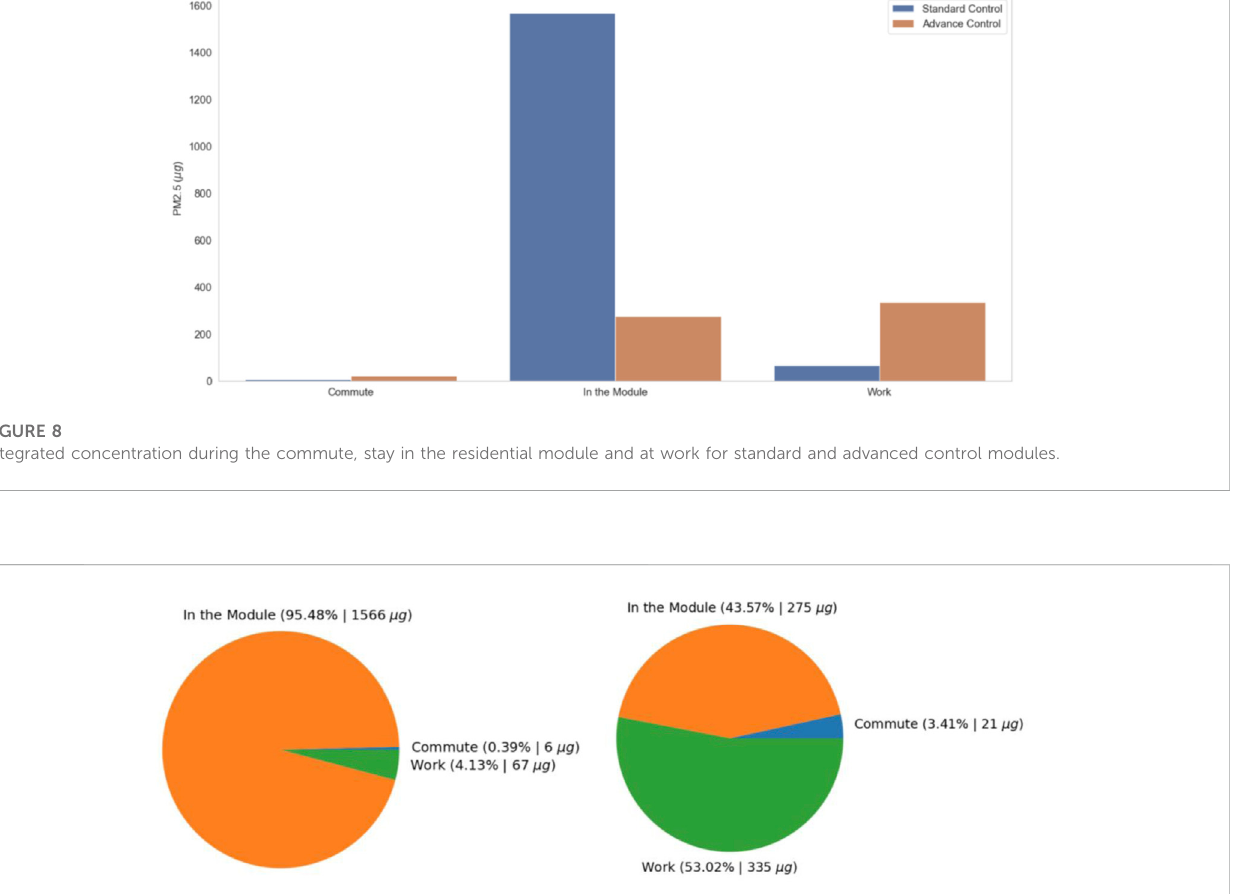
FIGURE 9 Apportionment of exposure to different environmentsand activities (A) Residential module with Standard control, (B) Residential module with advanced control.